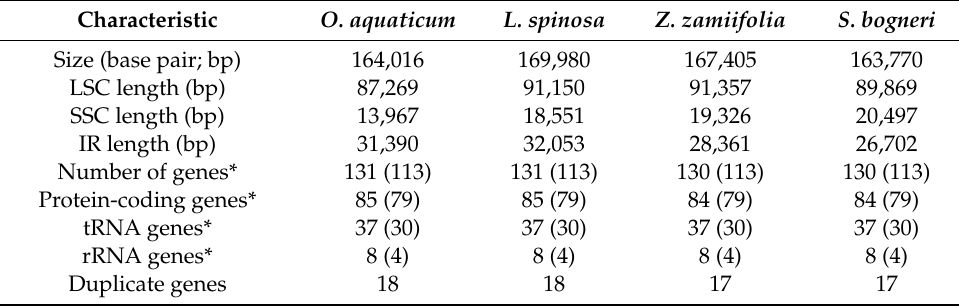
Figure 3. Colinear block-based analyses of gene arrangement in the chloroplast genomes. ( a ) O. aquaticum , ( b ) L. spinosa , ( c ) Z. zamiifolia , and ( d ) S. bogneri. The black block: transfer RNA genes, green block: transfer RNA genes with introns, white block: coding genes, and red block: ribosomal RNA genes. Light green and dark green blocks show differential existence of ycf1 and rps15 due to contraction and expansion of inverted repeats. Table 2. Genomic features of de novo assembled chloroplast genomes.